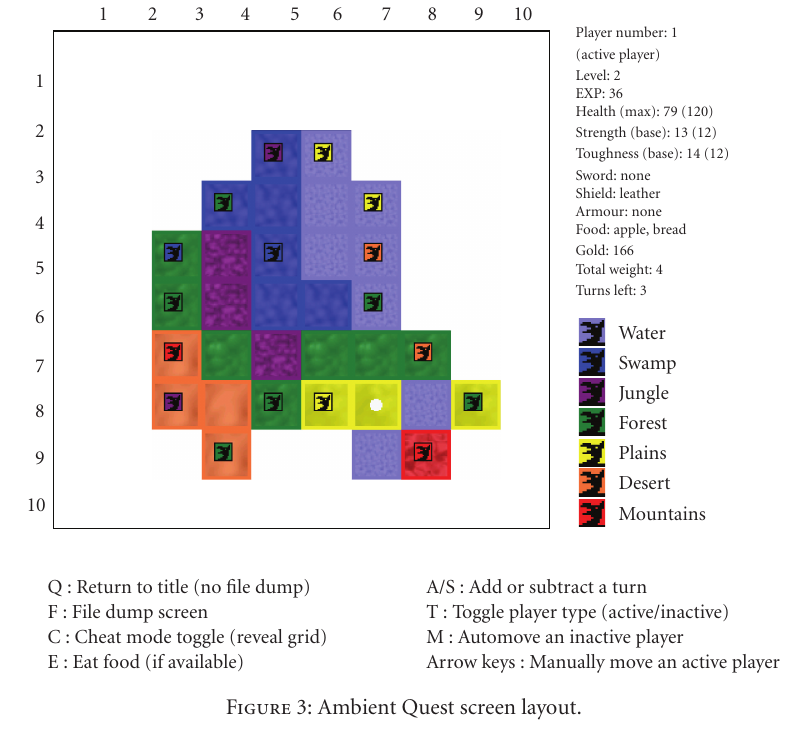
Figure 3: Ambient Quest screen